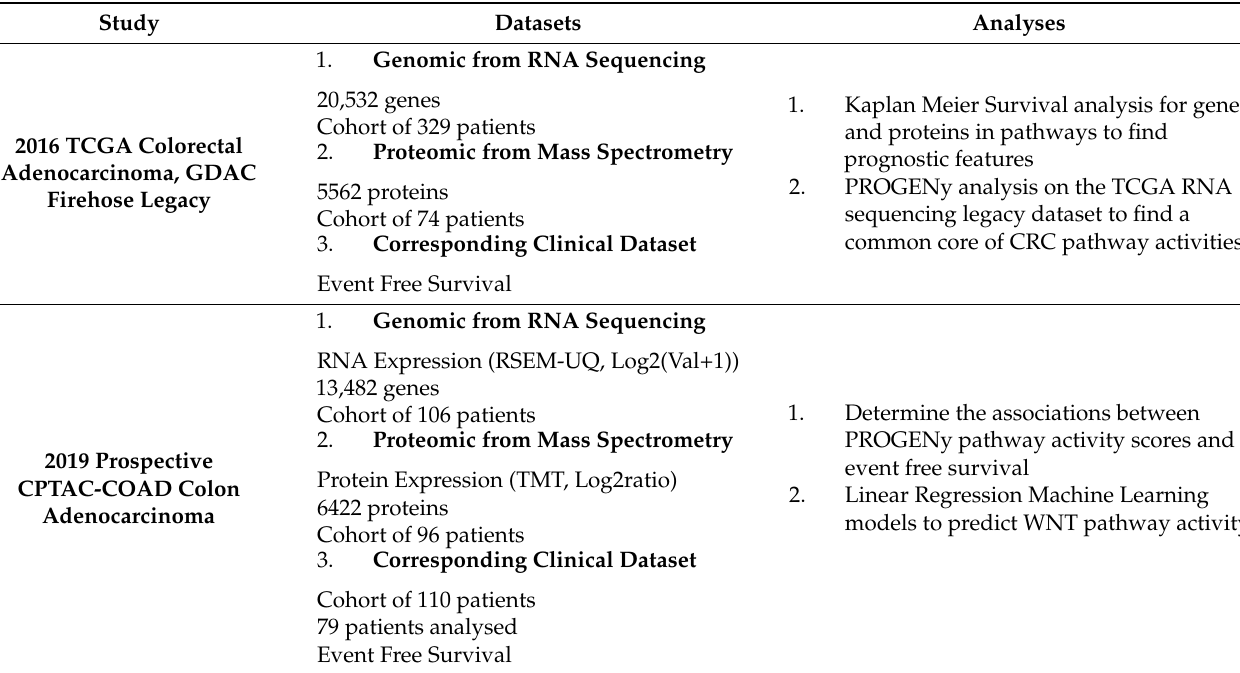
Table 7. Important key metrics of datasets and corresponding analyses performed for each dataset. The two studies used, TCGA Legacy and CPTAC, are located in the first column [39,40,50,51]. The “datasets” column represents the type of omic dataset used from the corresponding study in column one, with key metrics identified. The “analyses” column represents the type of analysis performed on each specified dataset. “RSEM” = RNA-sequencing by expectation-maximisation. “UQ” = upper quantile normalisation. “TMT” = tandem mass